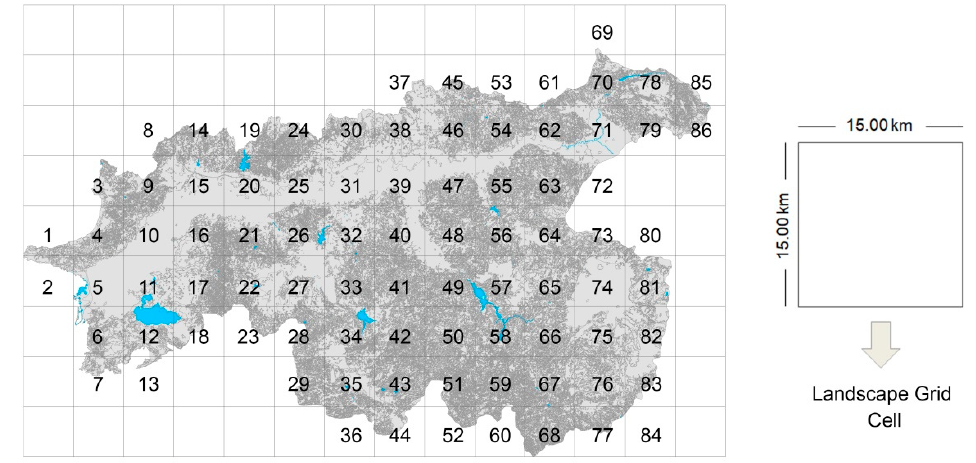
Figure 4. Landscape grid cells.